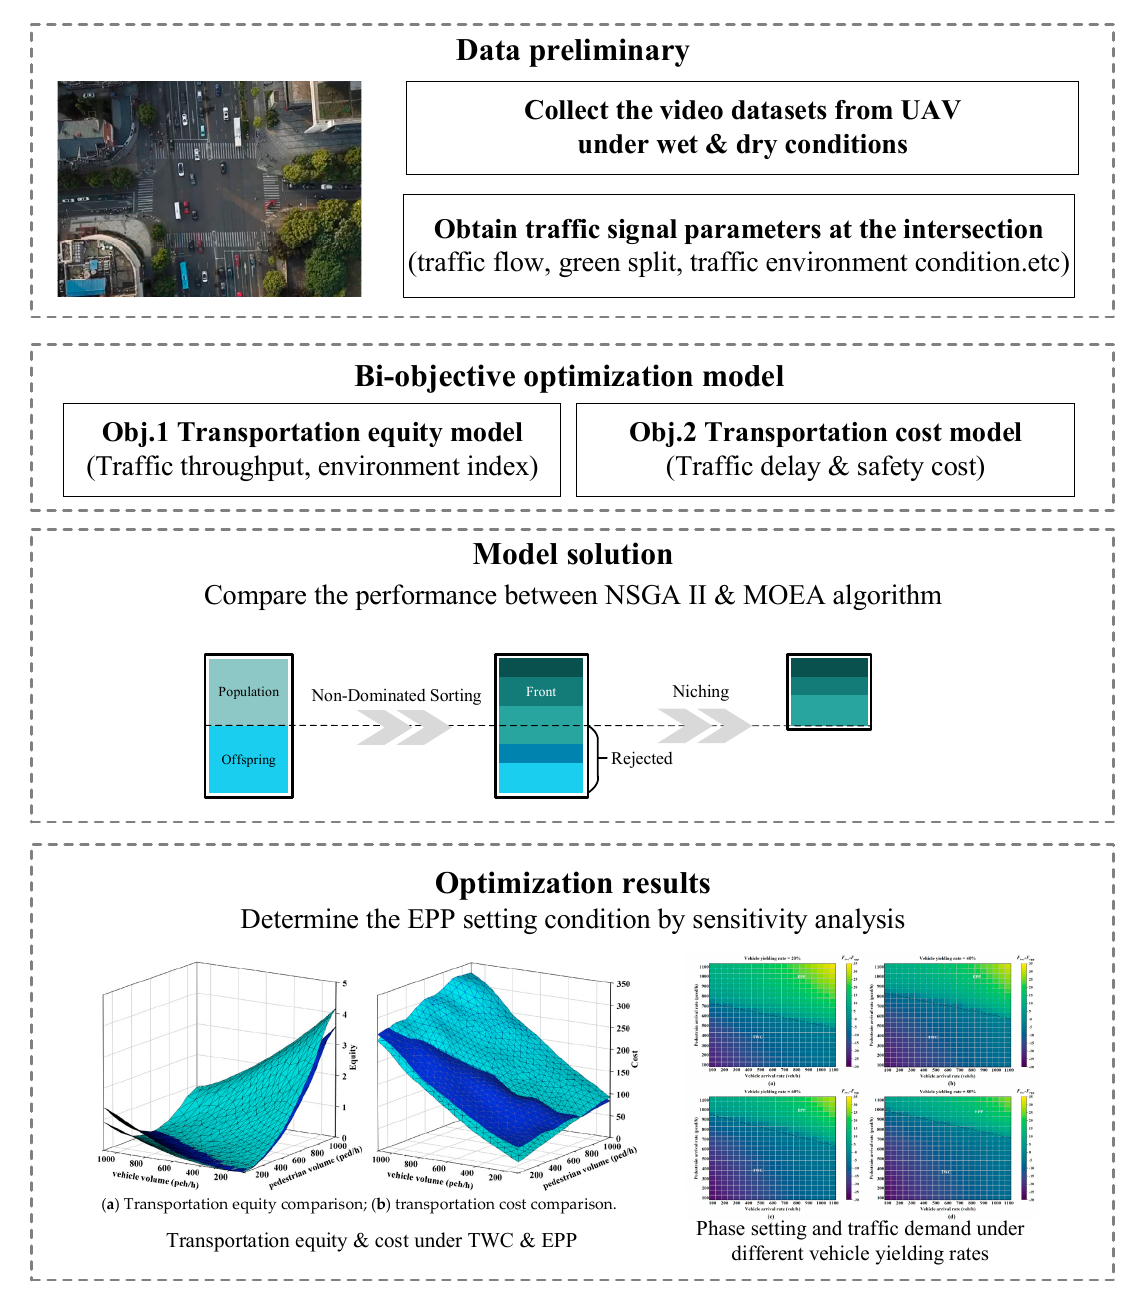
Figure 2. The proposed optimization framework. Table 1. Parameters in model validation.